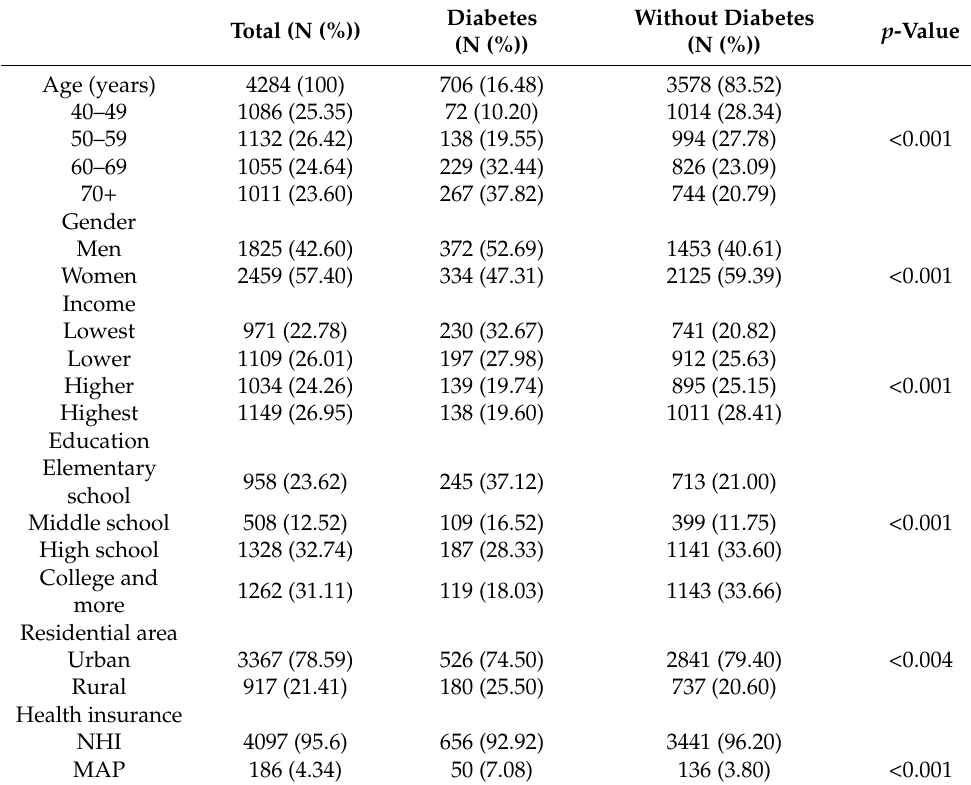
Table 1. Socio-demographic factors of the study participants.